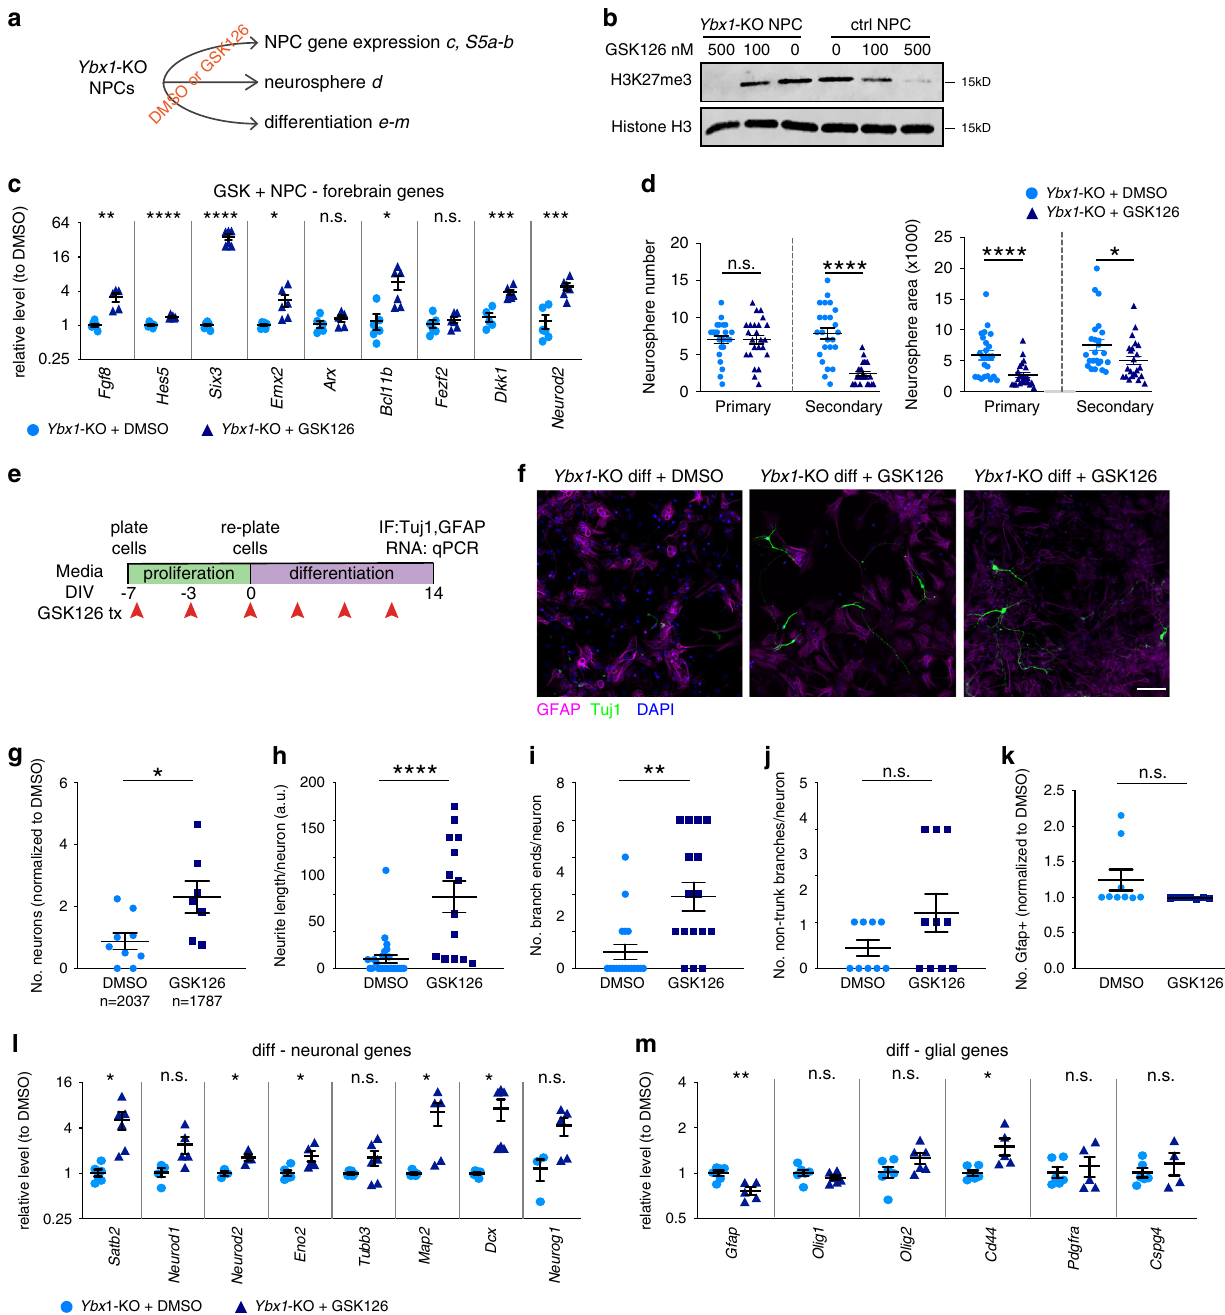
Fig. 7 PRC2 inhibition partially restores the appropriate gene expression, self-renewal, and neuron differentiation in Ybx1 -KO NPCs. a Diagram summarizing assays and the corresponding data panels. b WB analysis of acid-extracted histones from Ybx1 -KO and control NPCs treated with DMSO or GSK126 after 4 days. c RT-qPCR with TaqMan assays of Ybx1 -KO NPCs treated with DMSO or 500 nM GSK126 after 4 days. n = 6. d Number and area of primary and secondary neurospheres formed by Ybx1 -KO NPCs pretreated with DMSO or 500 nM GSK126 for 2 days. n = 24 images/genotype. e Diagram detailing in vitro differentiation of Ybx1 -KO NPCs treated with DMSO or 500 nM GSK126. Red arrowheads indicate the days at which DMSO or 500 nM GSK126 was replenished. f IF analysis of Ybx1 -KO cells treated with DMSO or 500 nM GSK126 at day 14 of differentiation. Quanti fi cation of g relative number of Tuj1-positive neurons, h neurite length, i number of branch points in axons, j number of non-trunk branches (not connected to an axon or dendrite), and k Gfap-positive (glial marker) cells in Ybx1 -KO differentiating cells treated with DMSO or 500 nM GSK126 ( n = 9 DMSO and 7 GSK126 images with cell numbers indicated). RT-qPCR with TaqMan assays of l neuronal genes and m glial genes in Ybx1 -KO differentiating cells treated with DMSO or 500 nM GSK126. n = 6, except n = 3 ctrl Neurod1 and Neurog1 . Data are presented as mean ± SEM for c , d , and g – m . P values by two-tailed unpaired t test are indicated. n.s. indicates not signi fi cant. *, **, ***, and *** indicate P < 0.05, 0.01, 0.001, and 0.0001, respectively, by one-way ANOVA or unpaired t test with Holm – Sidak correction. Source data are provided in Source Data fi le. P values: 7 c (Fgf8)-0.002, (Hes5)-<0.0001, (Six3)-<0.0001, (Emx2)-0.02, (Bcl11b)-0.02, (Dkk1)-0.0002 (NeuroD2)-0.0009; 7 d (secondary #)-<0.0001, 7 d (primary area)-<0.0001, 7 d (secondary area)-0.03; 7 g - 0.02; 7 h -<0.0001; 7 i -0.001; 7 l (Satb2)-0.01, (NeuroD2)-0.03, (Eno2)-0.02, (Map2)-0.02, (Dcx)-0.02; 7 m (Gfap)-0.004,